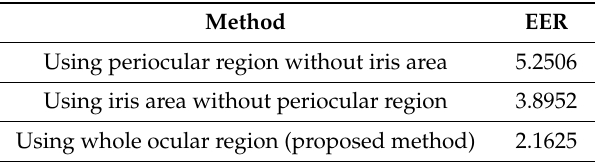
Table 10. Comparative EERs on CASIA-Iris-Distance database in case of using whole ocular region or using periocular region without iris area (unit: %).